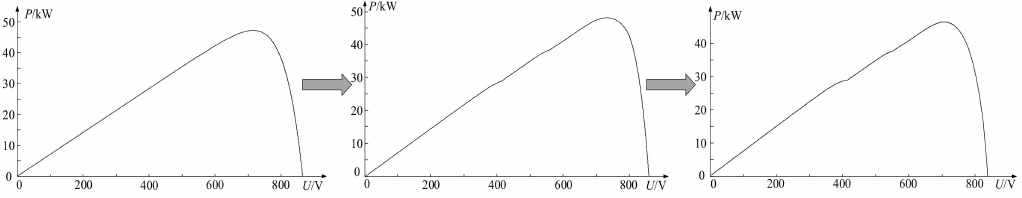
Figure 10. Power curve of IFA and FA under sudden change partial shading conditions